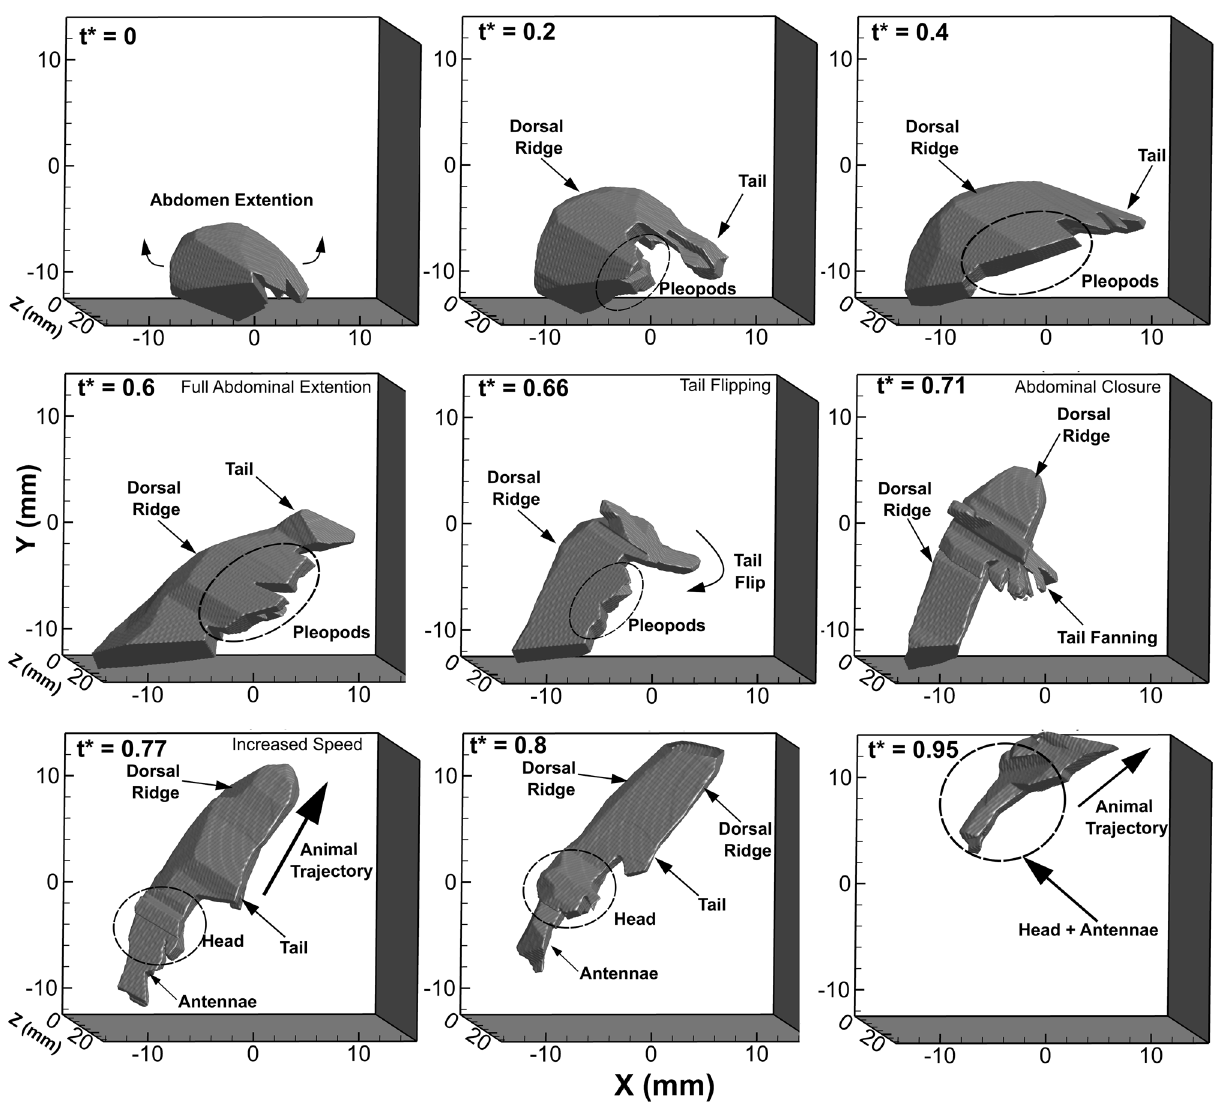
Figure 1. Time sequence of the reconstructed 3D visual hull of E. superba performing the caridoid escape response where t* is time non-dimensionalized by the total stroke period, which is 322 ms. The animal starts in a closed body position, fully extends the ventral cavity and then performs a rapid abdominal flexion and tail flip that leads to rapid acceleration of the animal to the upper right section of the viewing window. Note that the head and antennae of the animal are partially out of frame of the viewing window from t* = 0 to t* = 0.71 as well as the tail and dorsal ridge at t* = 0.95 leading to an exclusion of these body parts during the reconstruction of the 3D visual